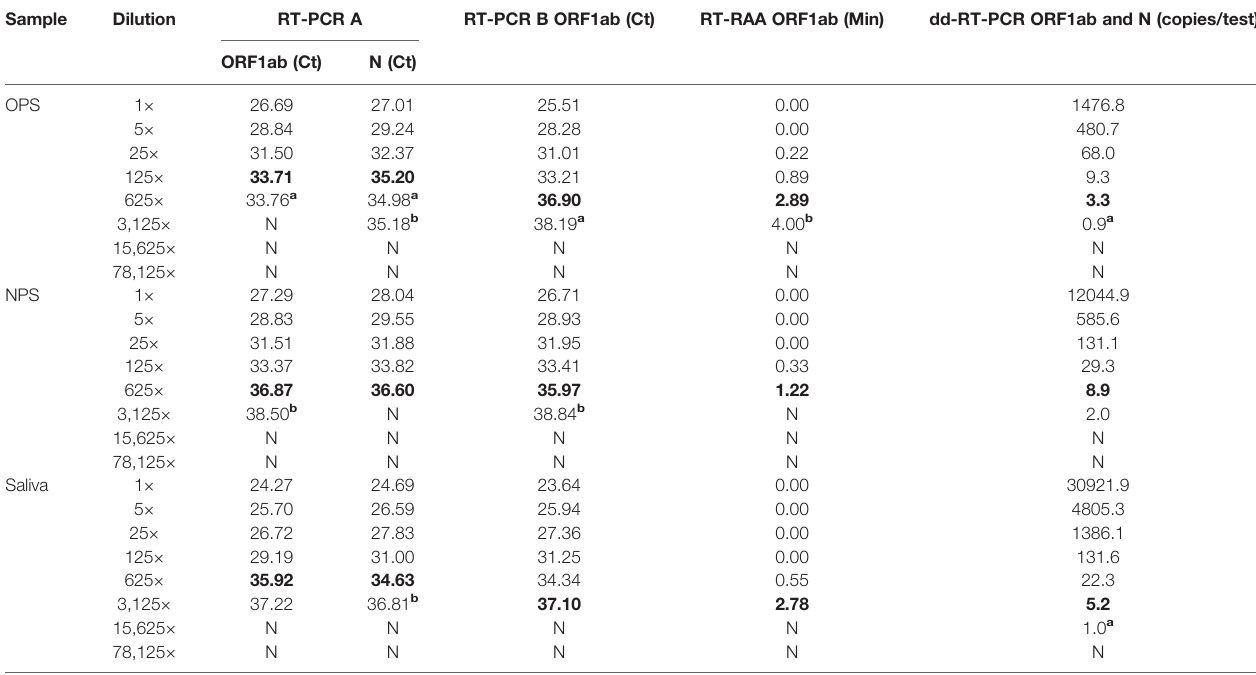
TABLE 3 | Detection of SARS-CoV-2 in serial fi ve-fold dilution of 3 samples. Sample